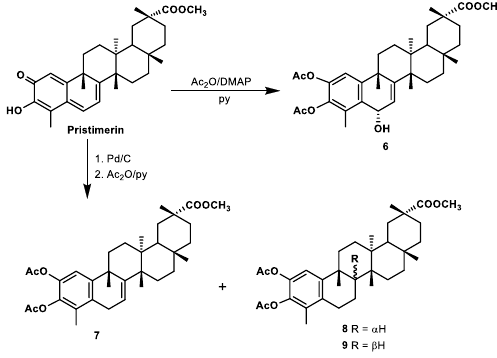
Scheme 1. Synthesis of analogues 6 – 9 from